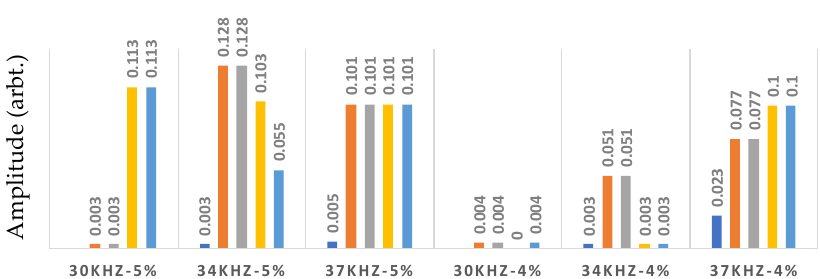
Figure 22. Bar graphs of detection length of the defect using the average value of all of the methods in the second set of tests.